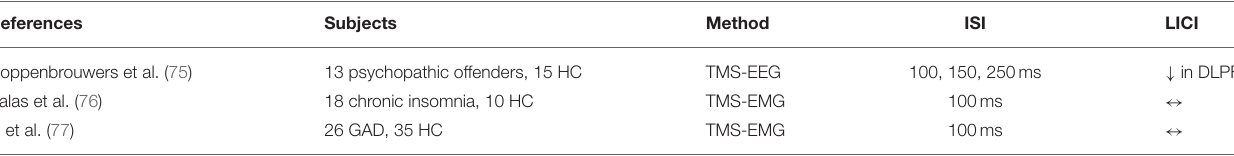
TABLE 7 | LICI in patients with other psychiatric disorders.